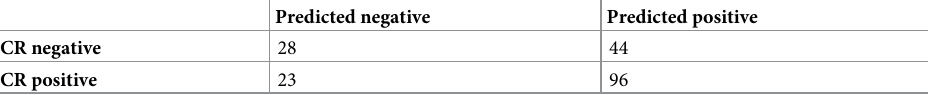
Table 1. Sensitivity and specificity of the prediction model, with samples above the cut-off of 50% probability to be positive according to the model considered predicted positive.